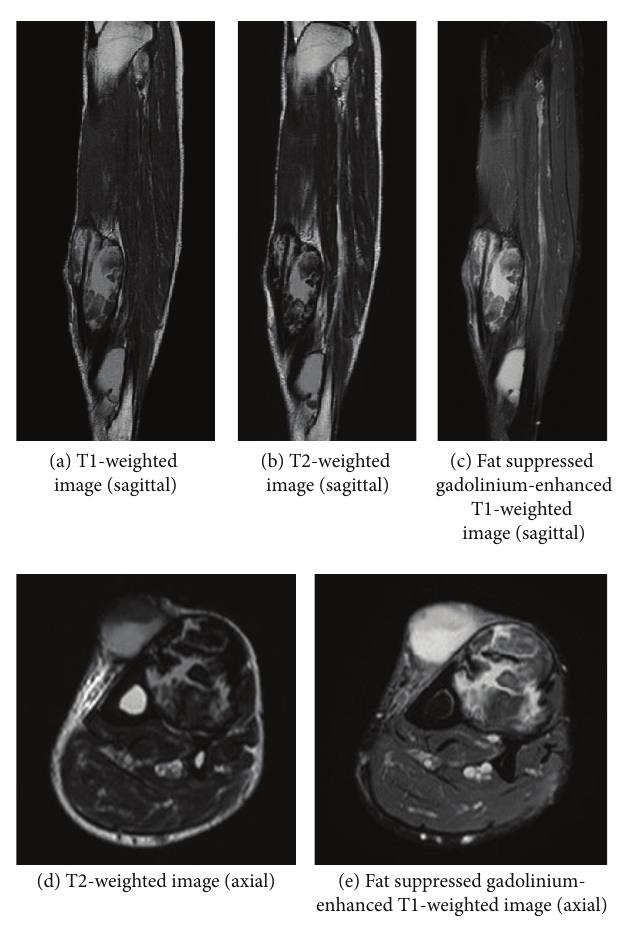
Figure 2: MRI revealed that the mass exhibited heterogeneous signals on T1- and T2-weighted images and the cystic lesions exhibited homogeneous signals on T1- and T2-weighted images (a, b, and d). Fat suppressed gadolinium-enhanced T1-weighted images revealed slight heterogeneous enhancement within the affected muscle with focal hypointense nonenhancing areas (c and e).